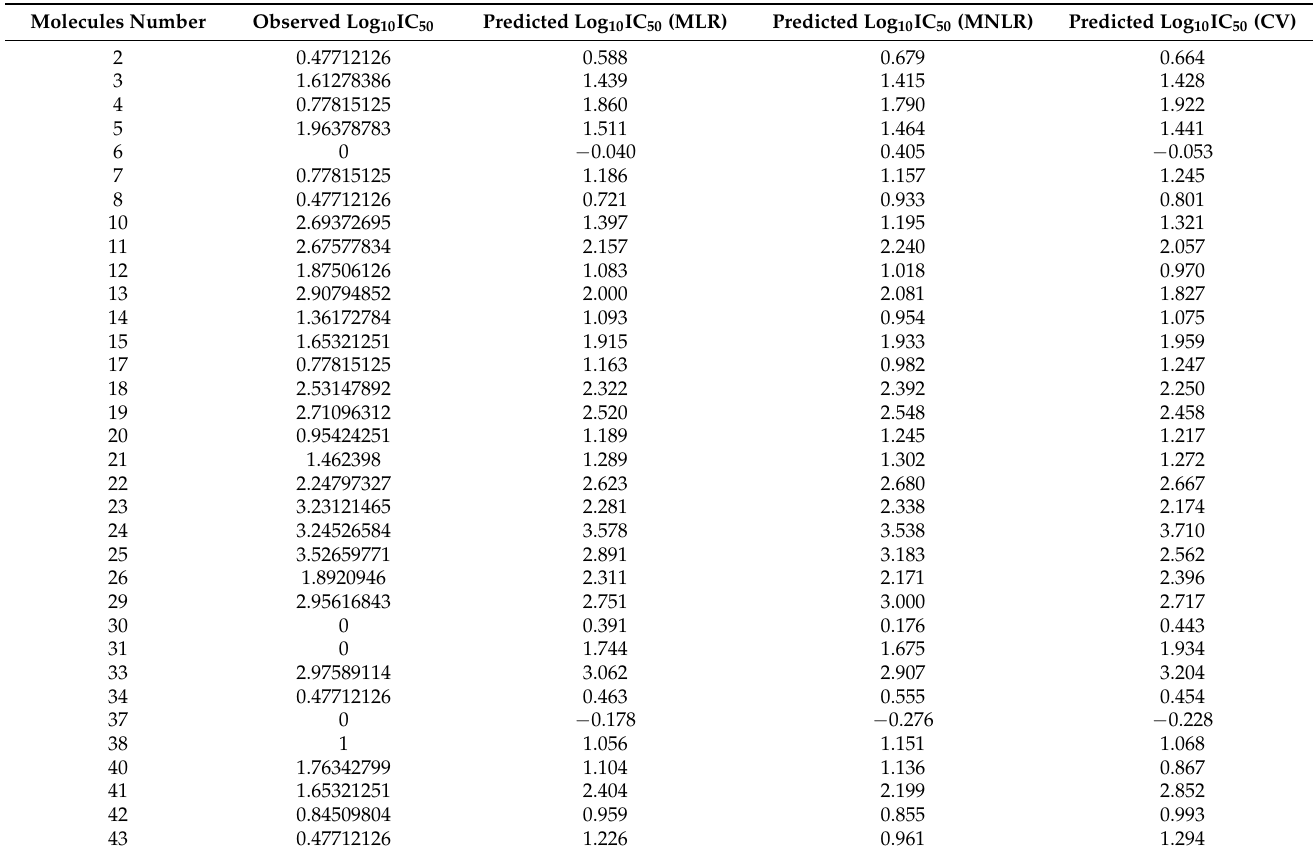
Table 5. Observed and predicted activity values from the QSAR models.